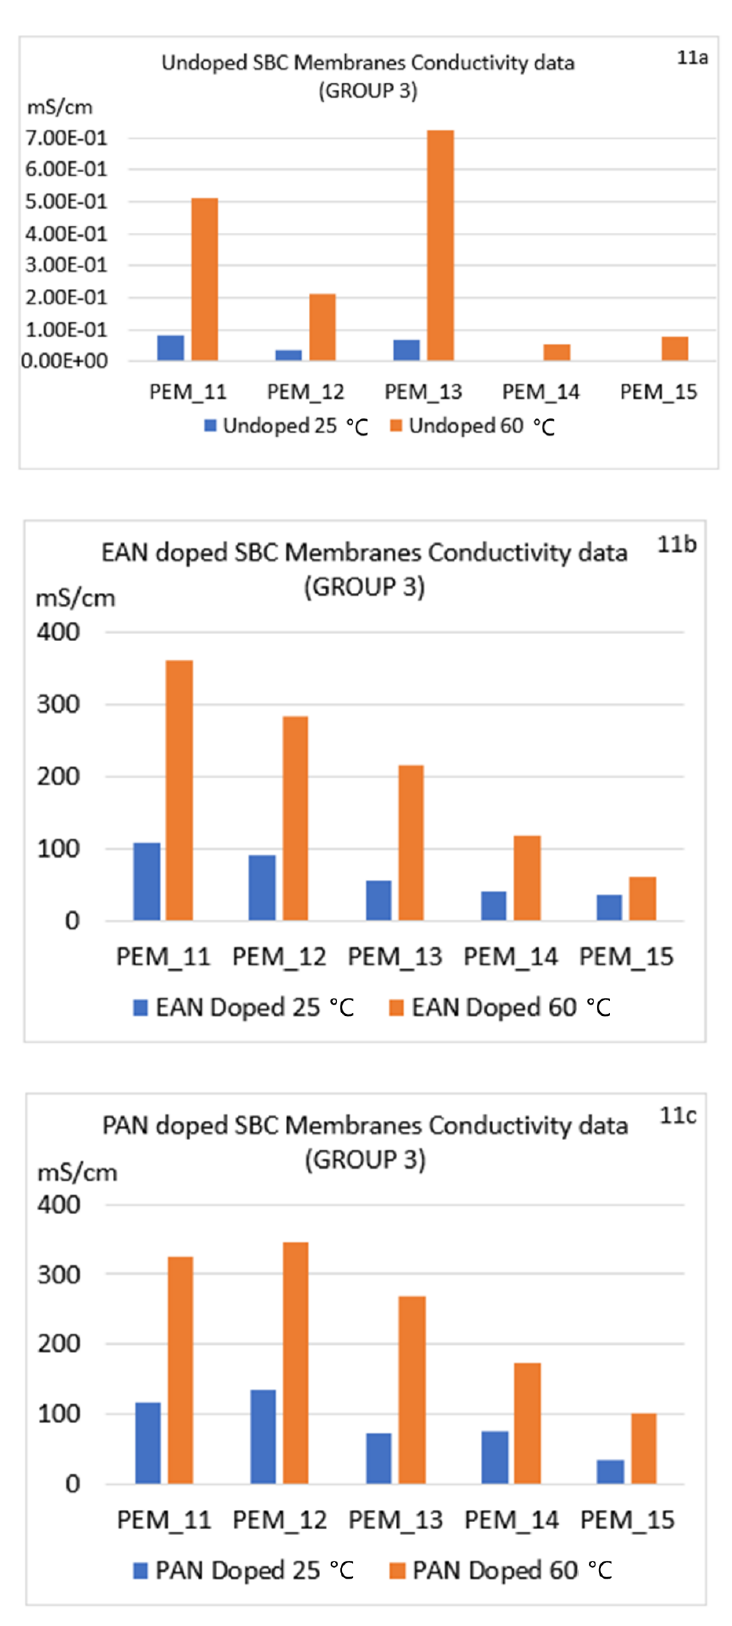
Figure 11. Comparison of conductivity values for nonannealed and annealed SBC membranes for all conditions for Group 3 membranes: PEM_11–PEM_15 (undoped and doped). ( a ) Undoped ( b ) EAN doped ( c ) PAN